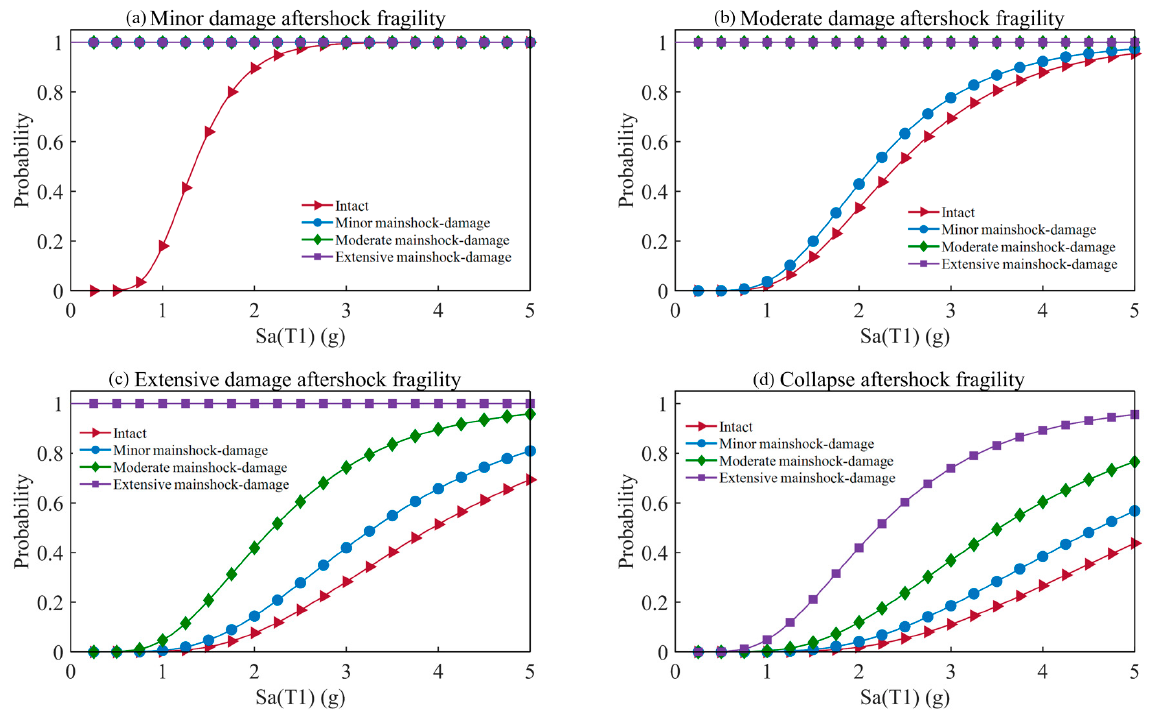
Figure 12. Aftershock fragility curves for different damage states ( a ) minor damage, ( b ) moderate damage, ( c ) extensive damage, and ( d ) collapse damage conditioned on different mainshock-damage states.